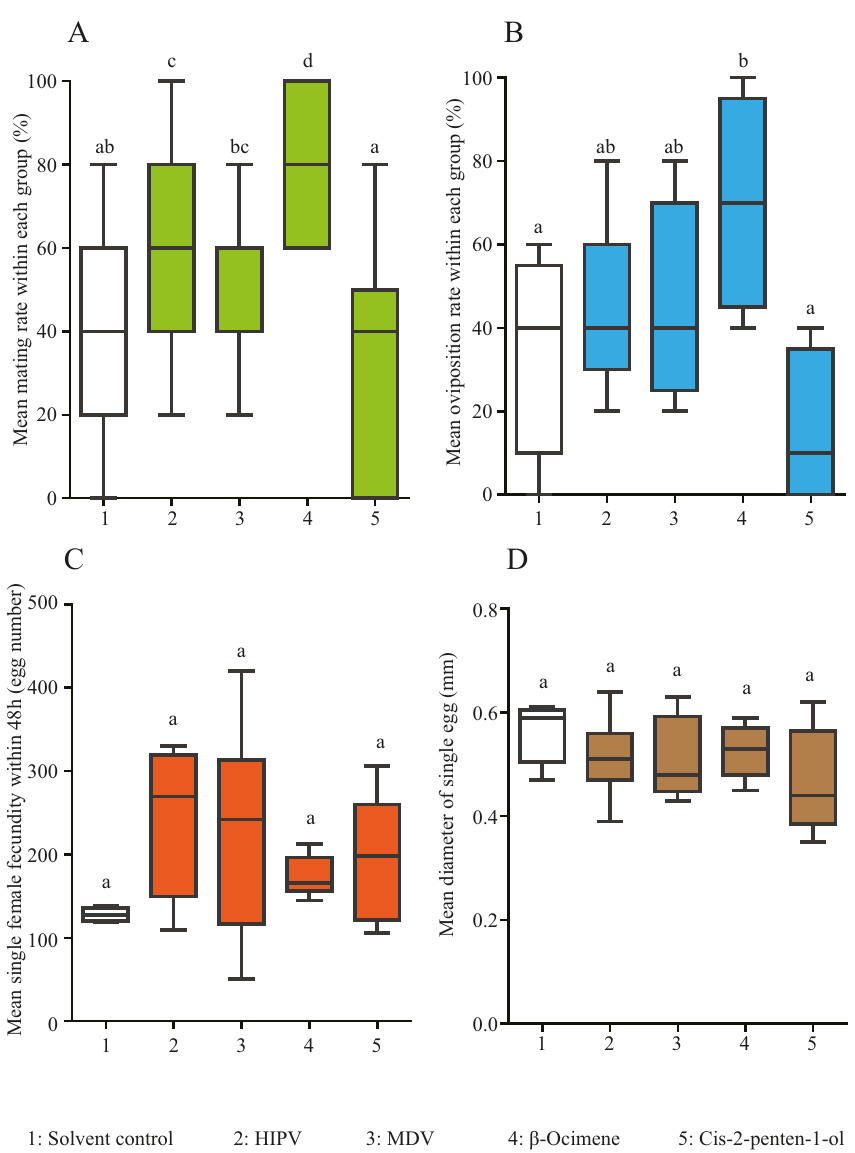
Figure 2. Comparison of influences of different volatiles on ( A ) mating rates calculated within each group (5 pairs, n = 74); ( B ) on oviposition rates calculated within each group (5 pairs, n= 16); ( C ) on average single female fecundity within 48 hours (n = 26) or ( D ) on average eggs sizes (n =38). 1: solvent control; 2: HIPV = herbivore-induced mulberry plant volatile blend; 3: MDV = mechanical damage-induced mulberry volatile blend; 4: β -ocimene standard chemical; 5: cis -2-penten-1-ol standard chemical. Error bars = SEM; Different letters on bars indicate significant differences according to ANOVA and Tukey HSD at p <